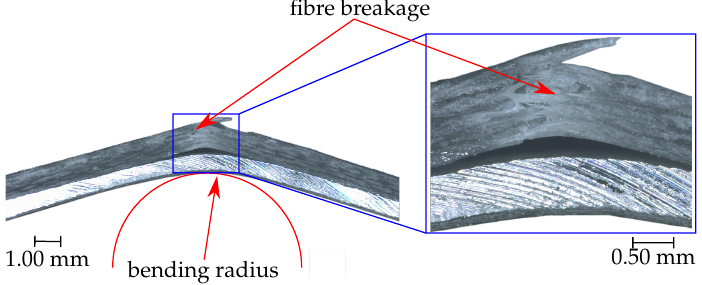
Figure 8. Failure of the thermoset laminate after the static three-point bending